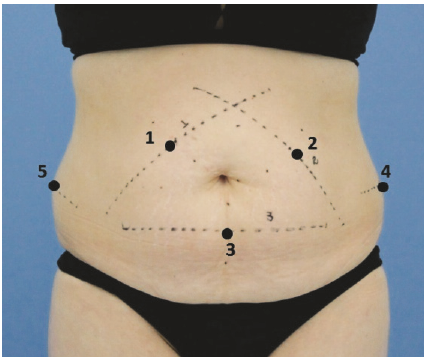
Figure 2: Points of evaluation and marked areas for the treatment. Each subject was treated at 1 or more areas for a total of up to 5 treatment areas; the areas were treated with either the medium or large applicator, based on the size of the localized fat